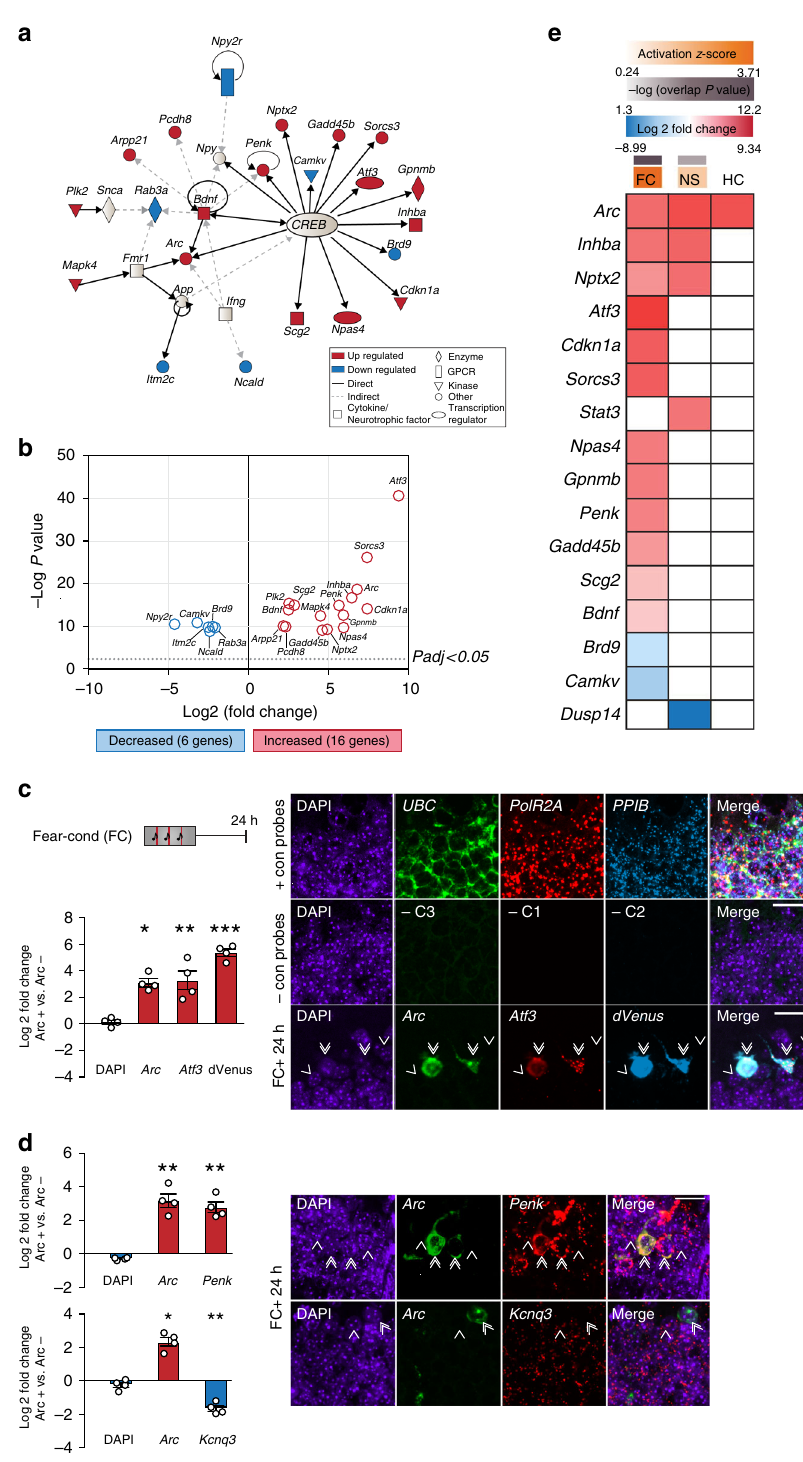
RNA sequencing, Arc (Fig. 3c: Log 2 fold change = 3.13 , P = 1.9 × 10 − 2 , Fig. 3d (upper): Log 2 fold change = 3.18 , P = 7.8 × 10 − 3 , Fig. 3d (lower): Log 2 fold change = 2.37 , P = 3.1 × 10 − 2 ) (Fig. 3c), Atf3 (Log 2 fold change = 3.02 , P = 7.5 × 10 − 4 ), dVenus (Log 2 fold change = 5.62, P = 6.0 × 10 − 6 ) (Fig. 3c) and Penk (Fig. 3d, upper) (Log 2 fold change = 2.96 , P = 2.5 × 10 − 3 ) were upregulated, while Kcnq3 (Fig. 3d, lower) (Log 2 fold change = – 1.5 , P = 6.9 × 10 − 4 )